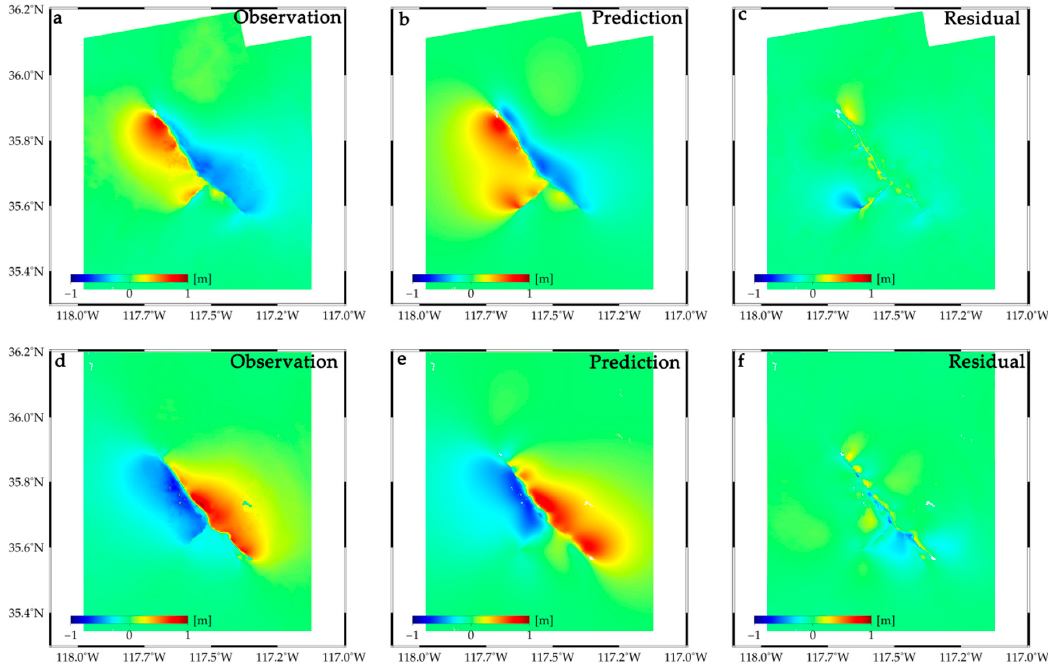
Figure 10. Coseismic LOS observations from ascending Sentinel-1 interferograms ( a ), predictions from our slip model ( b ), and residuals between of them ( c ). Observations from descending Sentinel-1 interferograms ( d ), predictions from our slip model ( e ), and residuals between them ( f ).